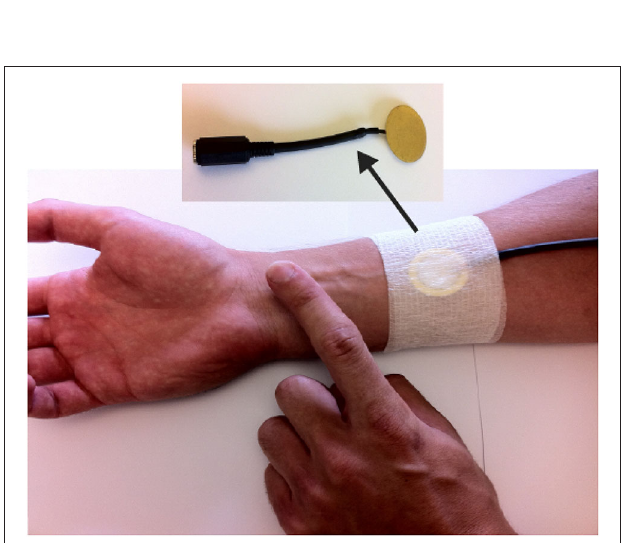
FIGURE 3 | In Coyle et al. (2012) a piezo-electric contact microphone was placed on the user’s arm and connected to a computer . Vibrations on the user’s arm were monitored to detect when the user tapped on their